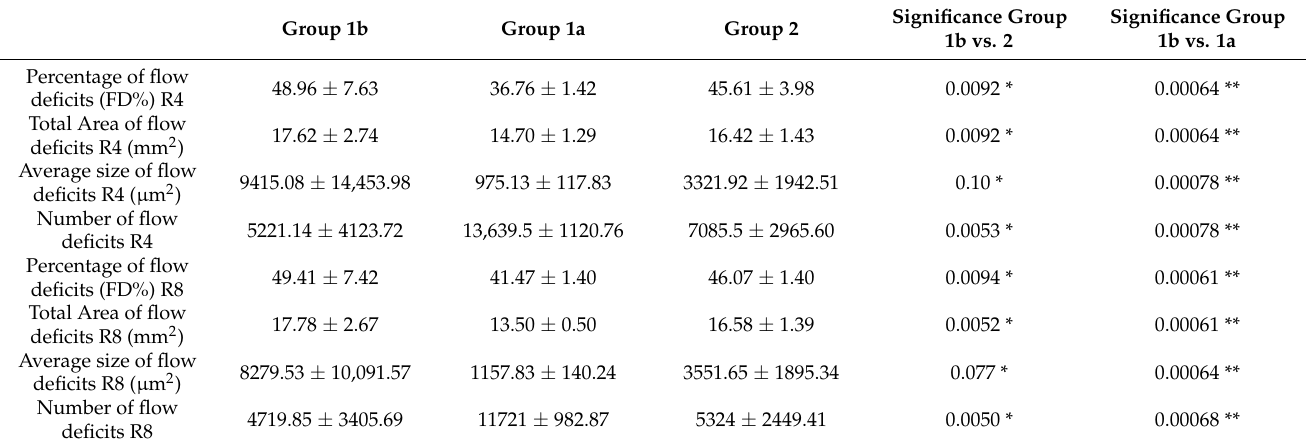
Table 3. SS-OCTA analysis of choriocapillaris flow: comparisons between eyes with retinal toxicity versus eyes under HCQ without toxicity and healthy controls. R4: analysis using the Phansalkar local thresholding method with a window radius of 4 pixels; R8: analysis using the Phansalkar local thresholding method with a window radius of 8 pixels; Group 1a: eyes of patients under HCQ without retinal toxicity; Group 1b: eyes with HCQ toxic retinopathy; Group 2: eyes of healthy controls; * t -test; ** Wilcoxon test.